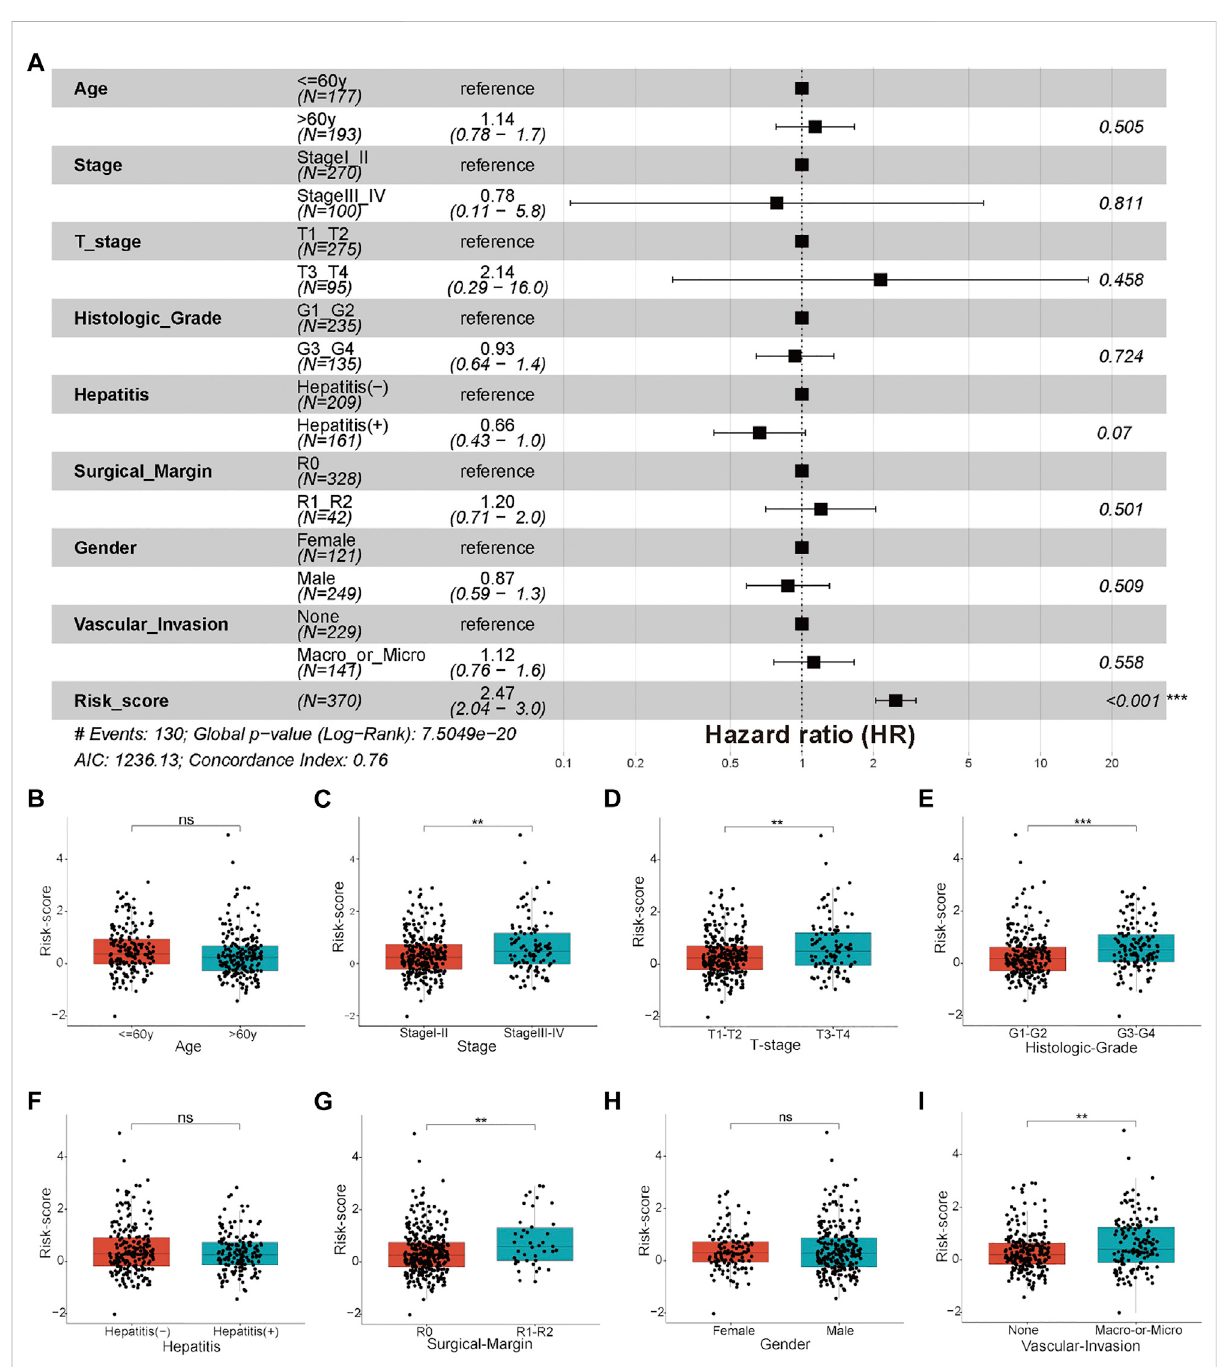
FIGURE 8 Clinicopathological features and clinical subgroup analysis. (A) Forest plot of clinicopathological features and risk scores in the TCGA-HCC cohort. (B – I) Boxplot results of the expression levels of the risk score among different clinical subgroups, including (B) age, (C) stage, (D) T stage, (E) histological grade, (F) hepatitis status, (G) surgical margin, (H) gender, and (I) vascular invasion. * p < 0.05, ** p < 0.01, and *** p < 0.001, ns: not signi fi